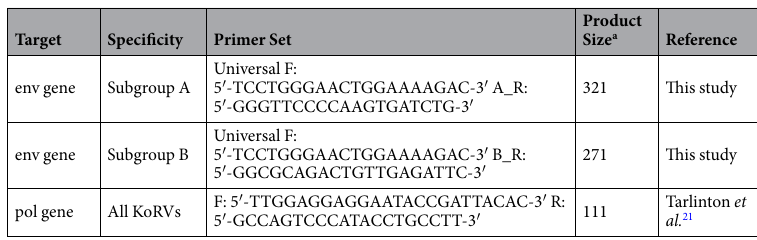
Table 1. PCR primers used for koala retrovirus (KoRV) quantification in the blood of free-living koalas ( Phascolarctos cinereus ). a Expected size predicted from alignment with the KoRV subgroup A and B representative genome sequences with Genbank accessions AF151794 and